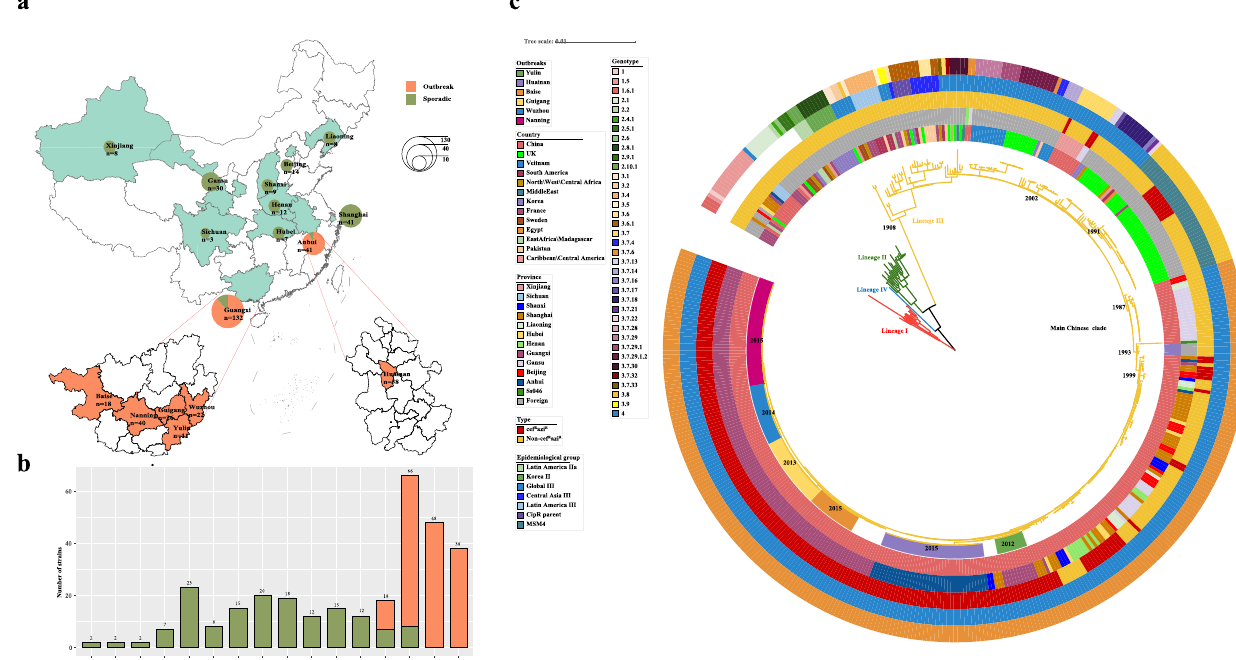
Fig. 1 | Distribution and phylogenetic analysis of Chinese S. sonnei strains, including the outbreak strains. a shows the regional distribution of Chinese S.sonnei isolates,includingsporadicandoutbreakstrains.Therewere307Chinese strains, including 155 outbreak strains and 152 sporadic strains from different regions of China. b shows the temporal distribution of Chinese S. sonnei isolates, including sporadic and outbreak strains. The outbreak strains were collected in 2015, 2016, 2019, and 2020. c shows a phylogenetic tree of global S. sonnei strains,